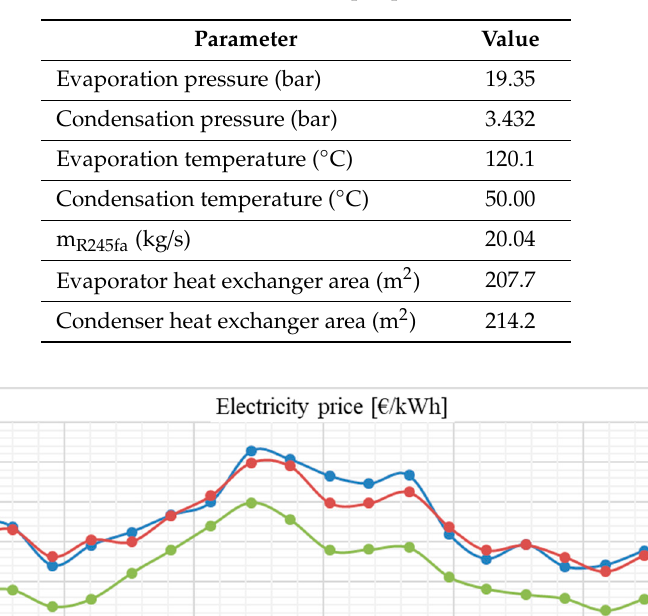
Table A4. Main ORC output parameters.